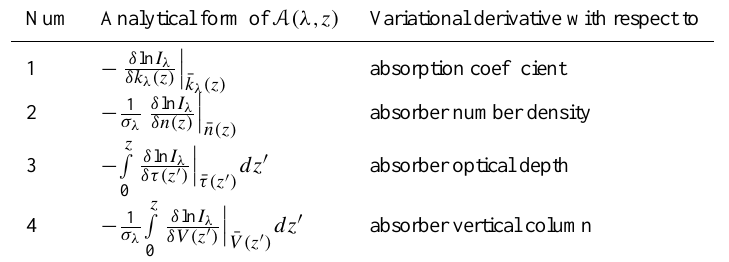
Table 2. General expressions for the air mass